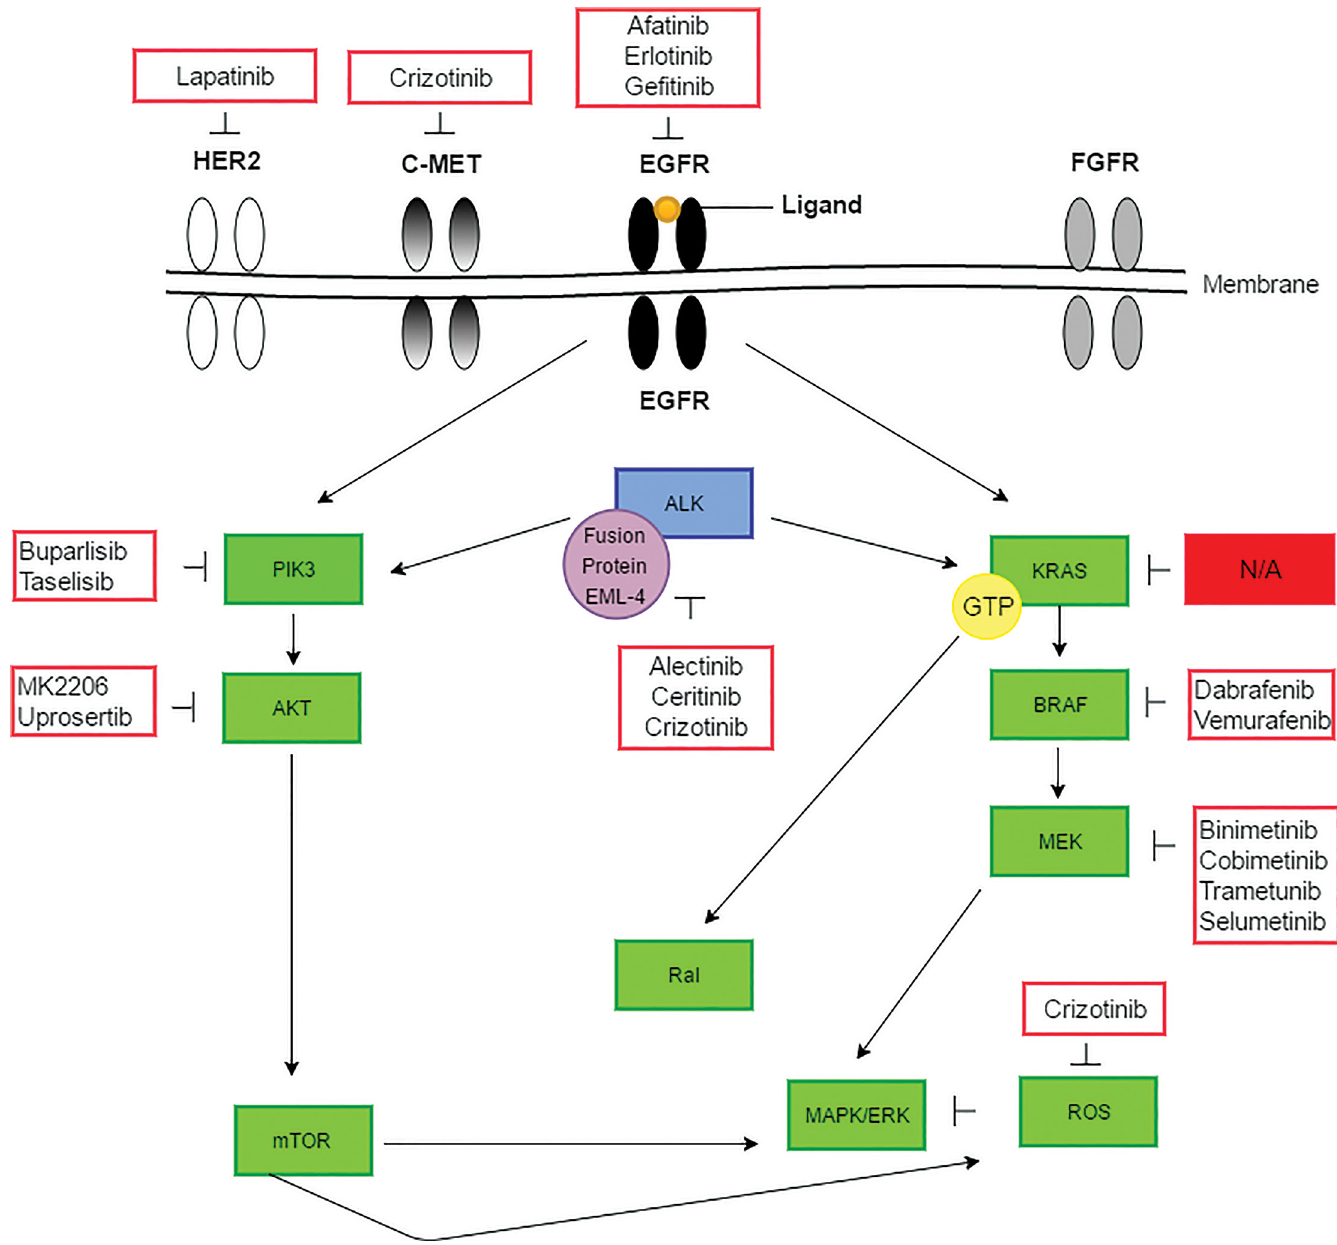
Figure 2. KRAS - related pathways. Targeted agents for pathogenic mutations involved in NSCLC are shown. (Comprehensive information available at: